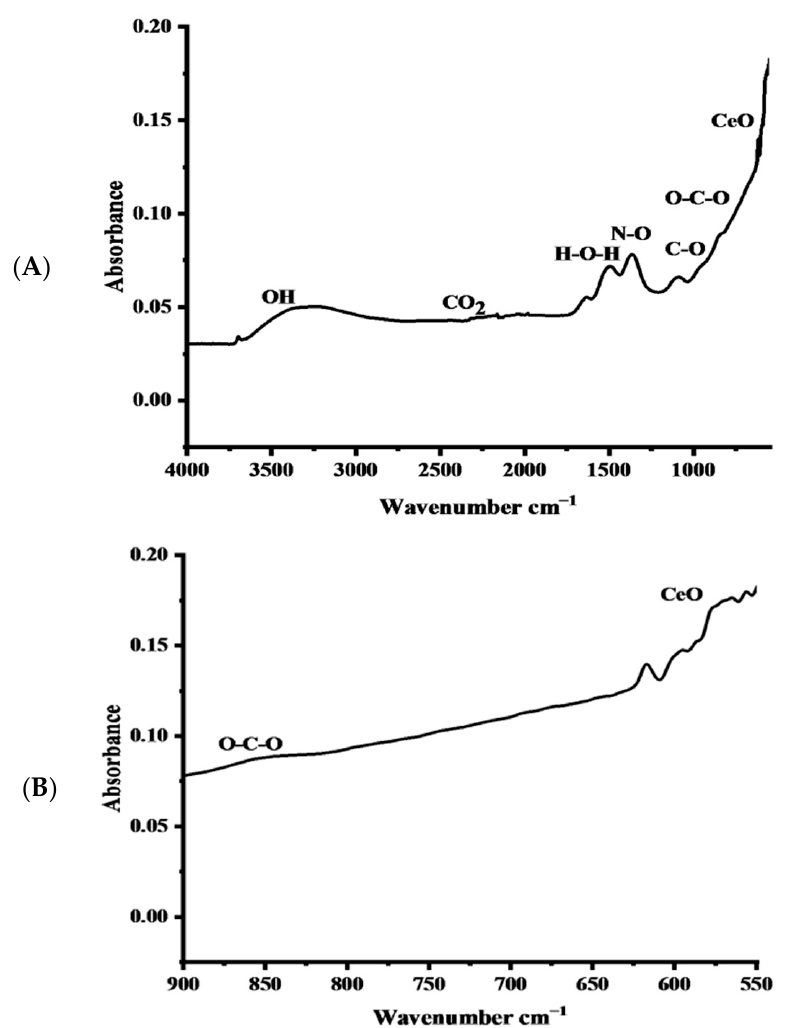
Figure 1. ( A ) FTIR spectrum of the synthesized Co-CeO 2 /C nanocomposite. ( B ) FTIR spectrum of the synthesized CeO 2 in the range of 500–900 cm − 1.